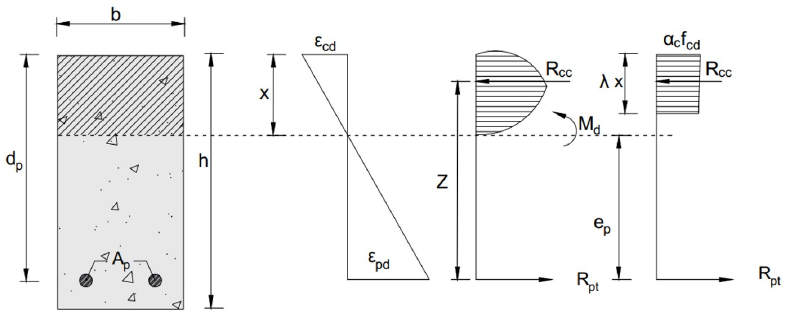
Figure 2. Stress-strain diagram of the rectangular